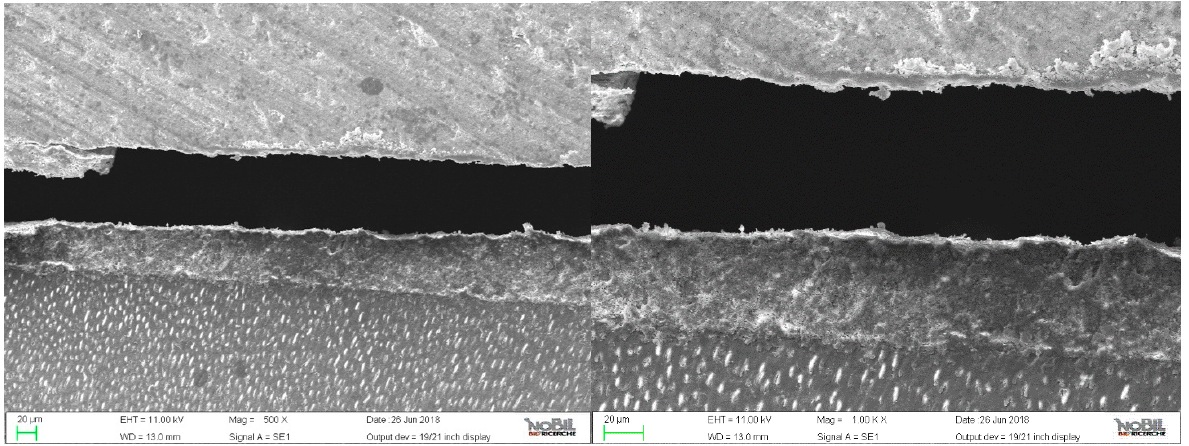
Figure 4. A mixed failure, with a prevalence in adhesive pattern, observed in a specimen treated with Estecem and stored in artificial saliva for 1 year.